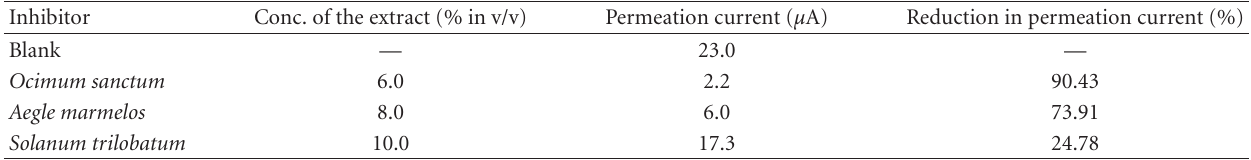
Table 5: Values of hydrogen permeation current for the corrosion of mild steel in 1N HCl alone and in the presence of